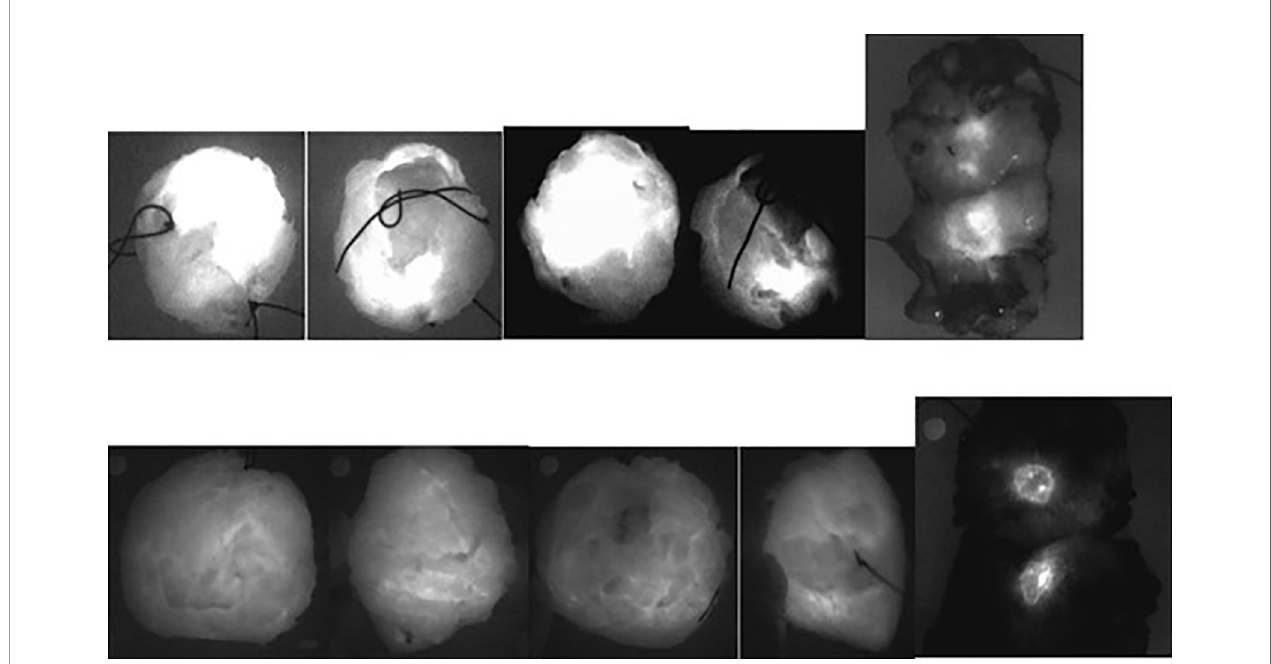
FIGURE 5 | Ex vivo NIR fl uorescence imagings of lumpectomy specimens (in the operating room) and of their slicings (in the department of Pathology) obtained: Upper panel: in patient n° 5 of Group 3 with a lobular invasive carcinoma, 19 × 10 × 11 mm large, close to the posterior margin (<1 mm) and to the anterior margin (4 mm) within a tumorectomy specimen sized 35 mm × 27 mm × 20 mm, histologically graded 1, with a maximum tumor to background fl uorescence ratio equal to 2.0: the corresponding views of the whole specimen showed clear fl uorescence at the surface of the specimen- Lower panel: in patient n° 6 of Group 3 with a canalar invasive carcinoma, 14 mm large within a tumorectomy specimen sized 62 mm × 75 mm × 35 mm, histologically graded 2 and with a maximum tumor to background fl uorescence ratio equal to 4.0: the tumor was well centered and the corresponding views of the whole specimen showed no clear fl uorescence at the surface of the